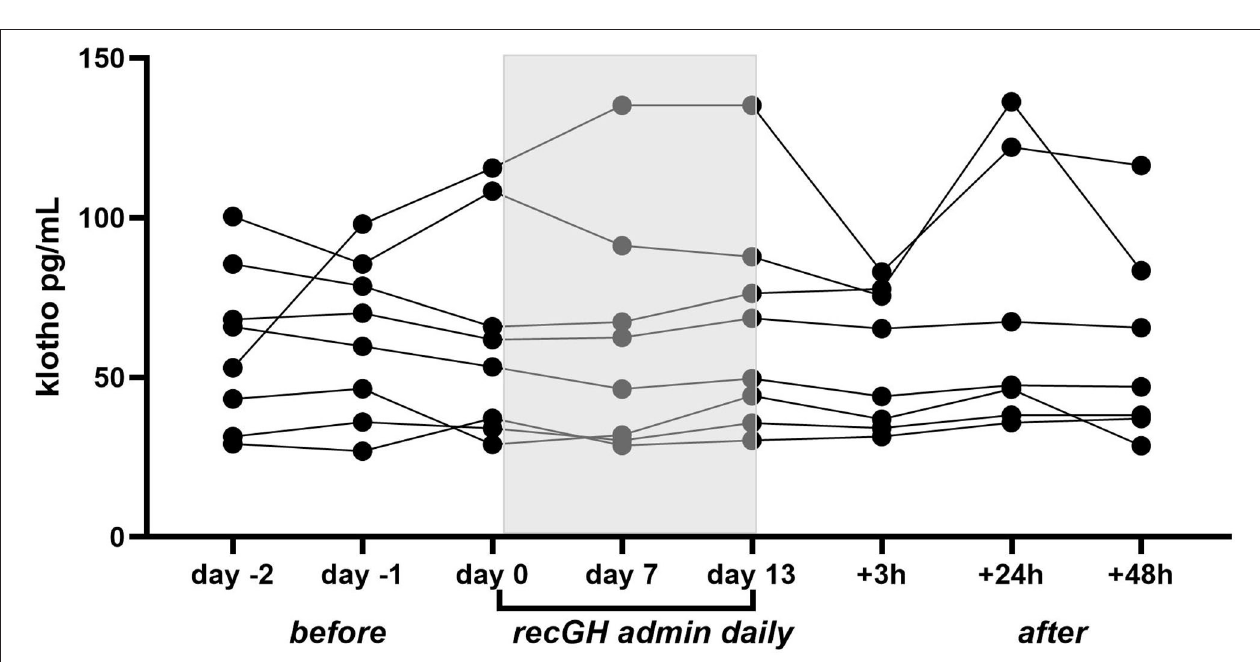
FIGURE 2 | Klotho serum levels in eight participants administered with recGH (0.008–0.051 IU/kg body weight/day) for 2 weeks. Serum samples were analyzed prior to the treatment period (day − 2, day − 1, and day 0), during treatment (day 7 and 13), and 3, 24, and 48h post-treatment.